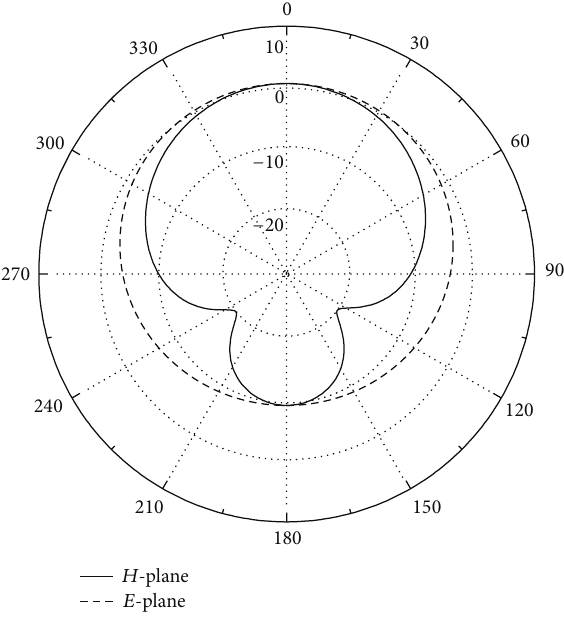
Figure 12: Radiation patterns of the proposed